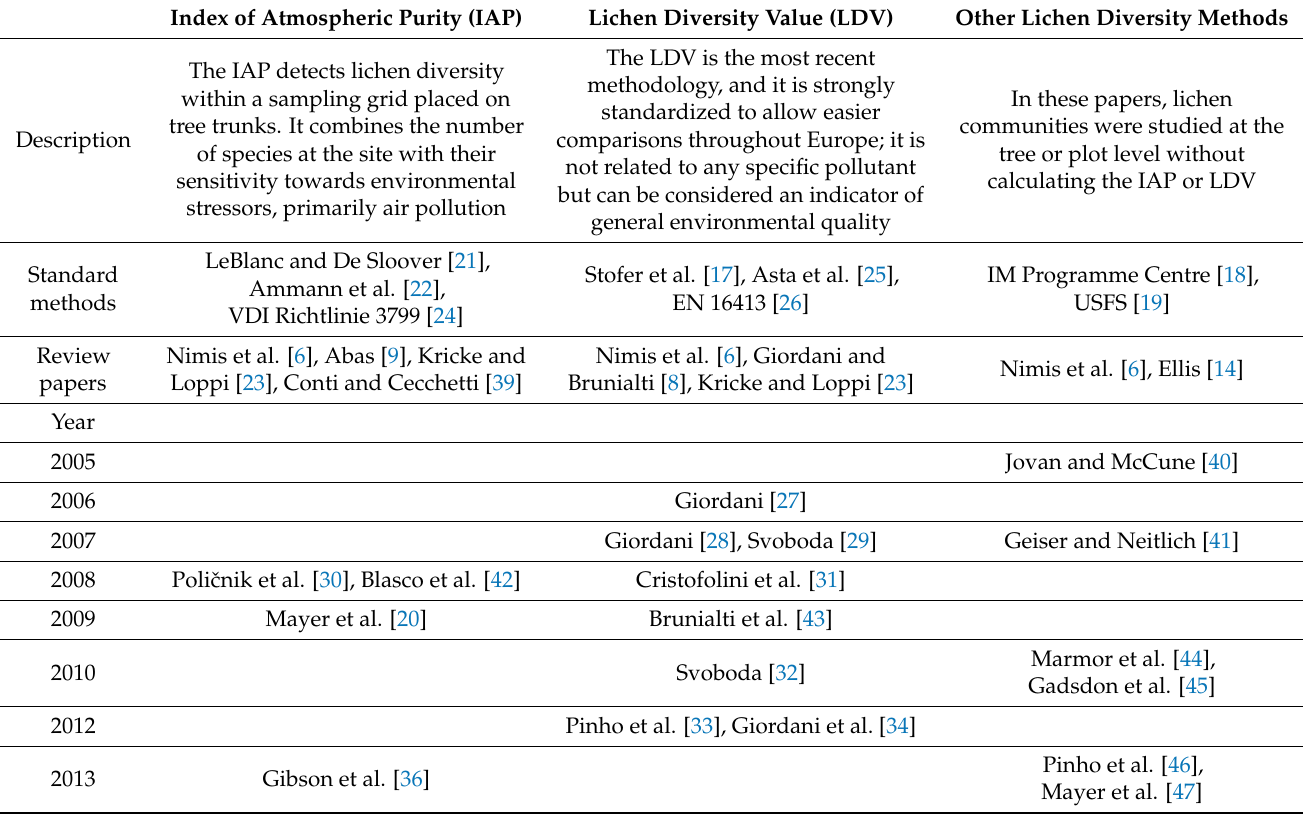
Table 1. Lichen communities and lichen diversity indices: list of selected